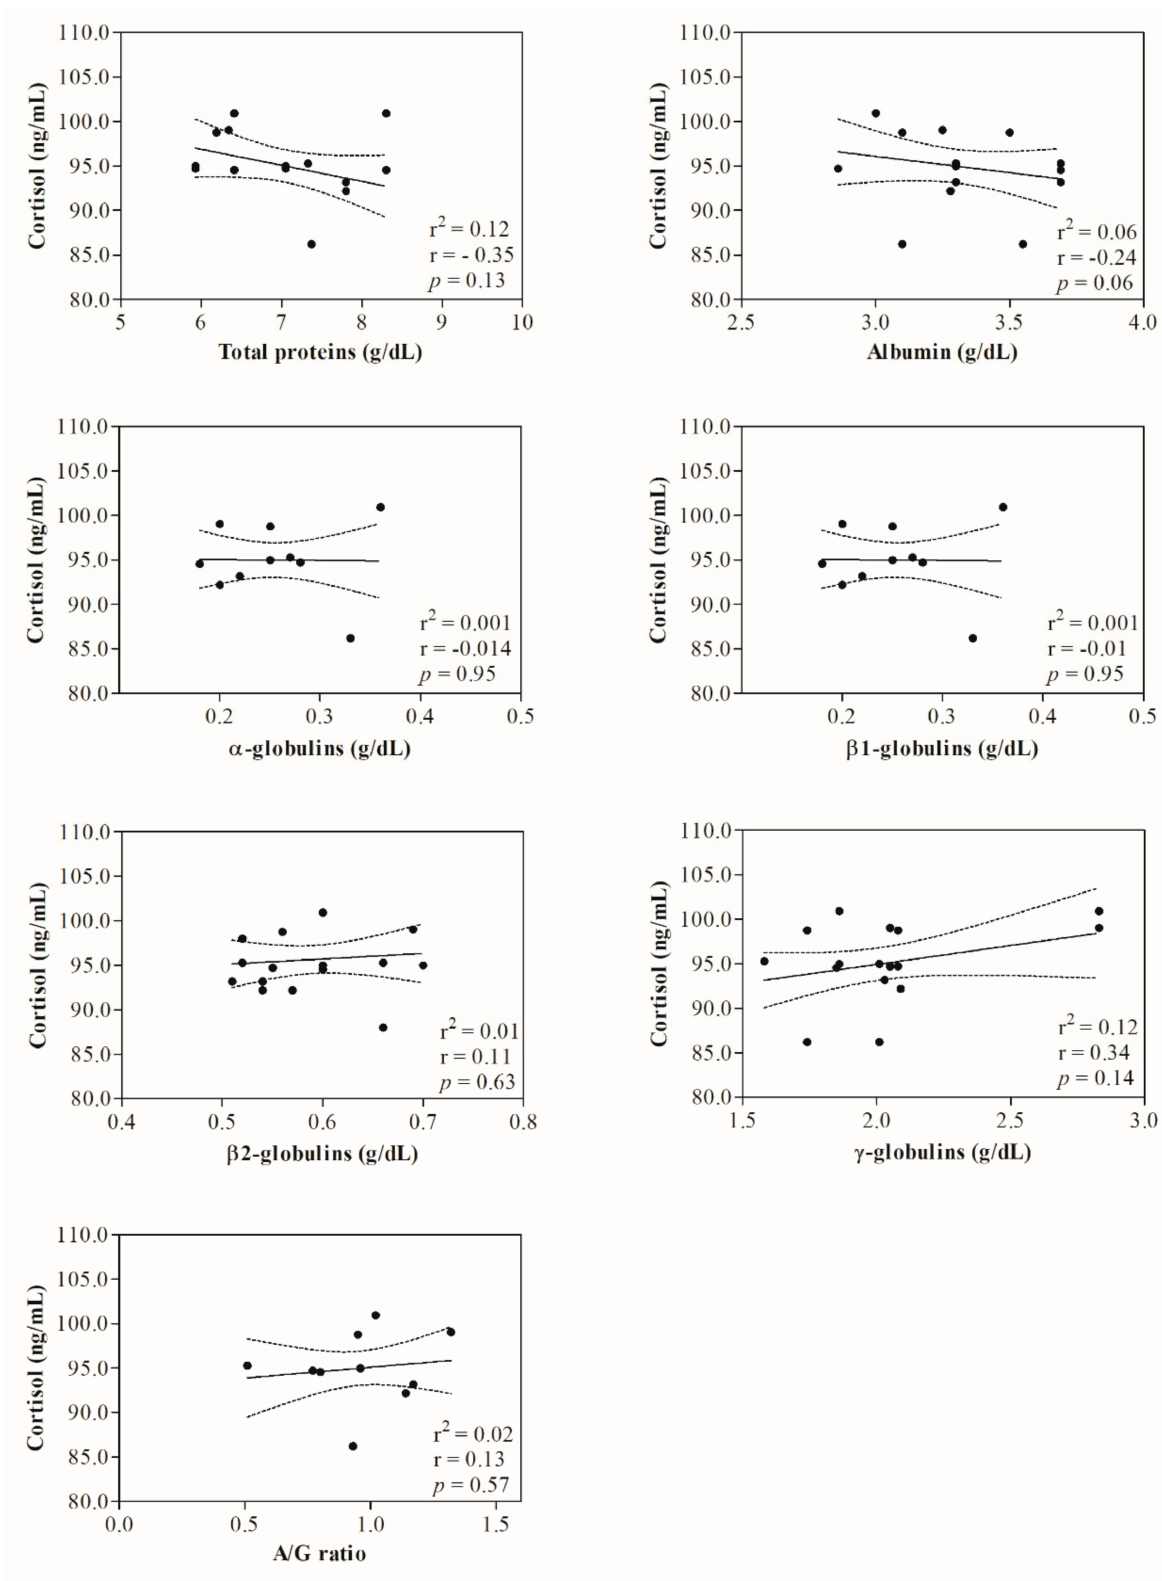
Figure 2. Linear regression model results found between the serum values of cortisol and the serum concentration of serum total proteins, albumin, α -, β 1-, β 2-, γ -globulins and the A/G ratio measured in ewes before the shearing procedure (T PRE